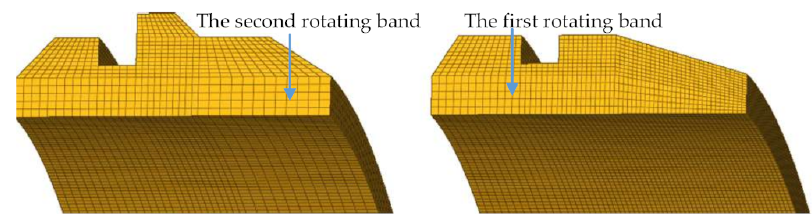
Figure 12. Cross-section of finite element model of the rotating bands.